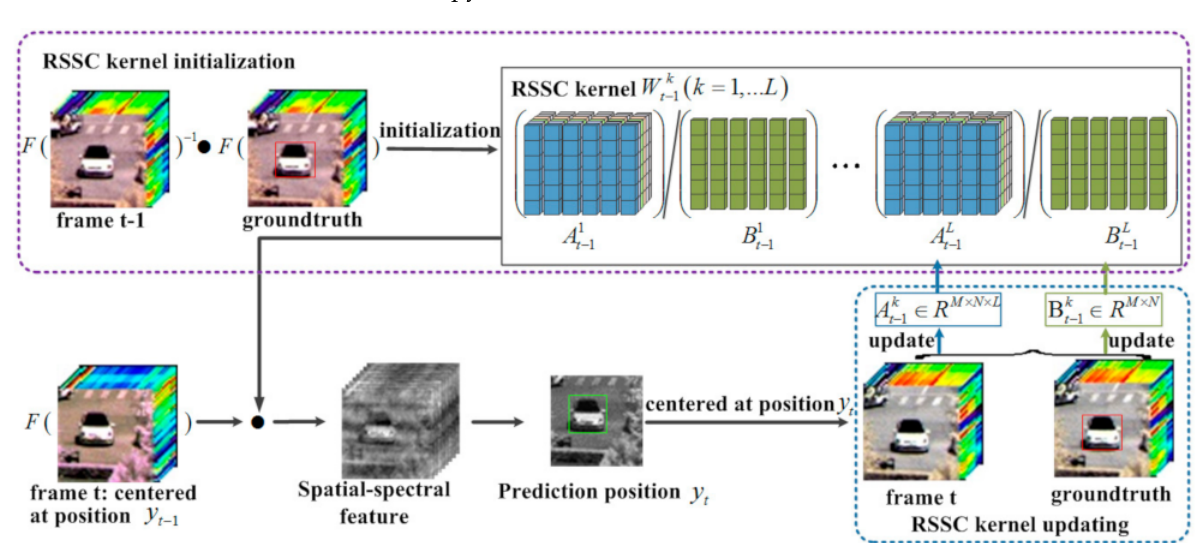
Figure 8. The initialization (purple box) and updating (blue box) process of the proposed real-time spatial-spectral convolution (RSSC) kernel. In the frame t − 1, RSSC kernels are initialized using the search region of interest centered at position y t − 1 and ground-truth bounding box of the object. For the new frame t , spatial-spectral features are extracted using the initialized RSSC kernel to estimate the object position y t . Then, RSSC kernels are updated using the search region of interest and bounding box centered at y t . For calculation convenience, here we update the numerator A k B k of the RSSC kernel separately. F and F − 1 denote the FFT and inverse FFT, t